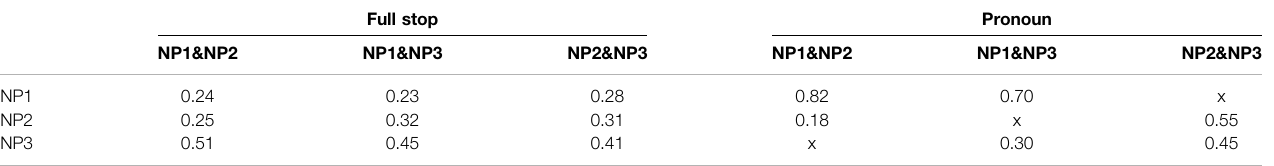
TABLE 2 | Proportion of next-mention in Experiment 1, per referent, per prompt type, per ambiguous pair. The vertical columns sum toone (e.g., the re-mention rates in the NP1&NP2 condition are distributed 0.24/.25/.51 across the three referents).